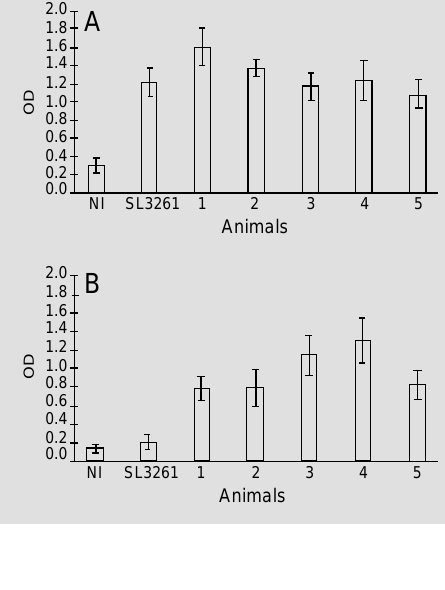
Figure 5 - Secreted antibody re- sponse of mice orally immunized with S. typhimurium HG3 cells. The gut homogenates of 5 mice immunized with 10 9 cfu of HG3 were analyzed individually (num- bers 1 to 5) by IgA-ELISA for Salmonella LPS (A) and the CFA/ I subunit (B). Results obtained with pools of non-immunized (NI) and SL3261-inoculated (SL3261) mouse gut homoge- nates are also shown. All samples were diluted 1:20 in PBS before testing. Results are reported as the mean ± SD of quadruplicate wells for two iden- tical